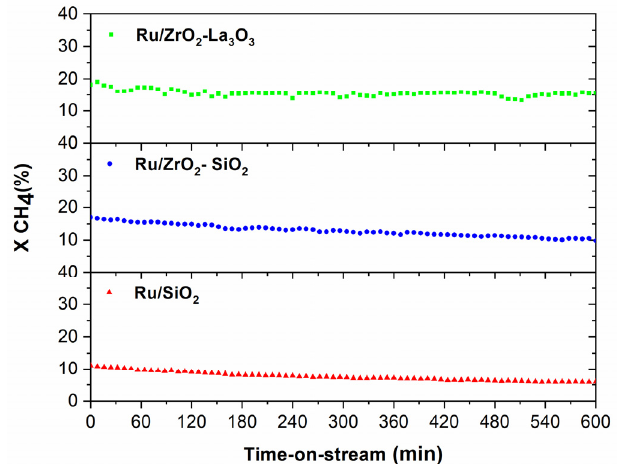
Figure 10. Methane conversion versus time-on-stream during DRM reaction carried out in the CR at 500 ◦ C over supported Ru catalysts; Ru/ZrO 2 -La 2 O 3 ( (cid:4) ), Ru/ZrO 2 -SiO 2 ( • ), and Ru/SiO 2 ( (cid:78) ); Feed composition: CH 4 : CO 2 : He = 10:10:80; Total flow rate = 100 mL/min: P = 1 bar.